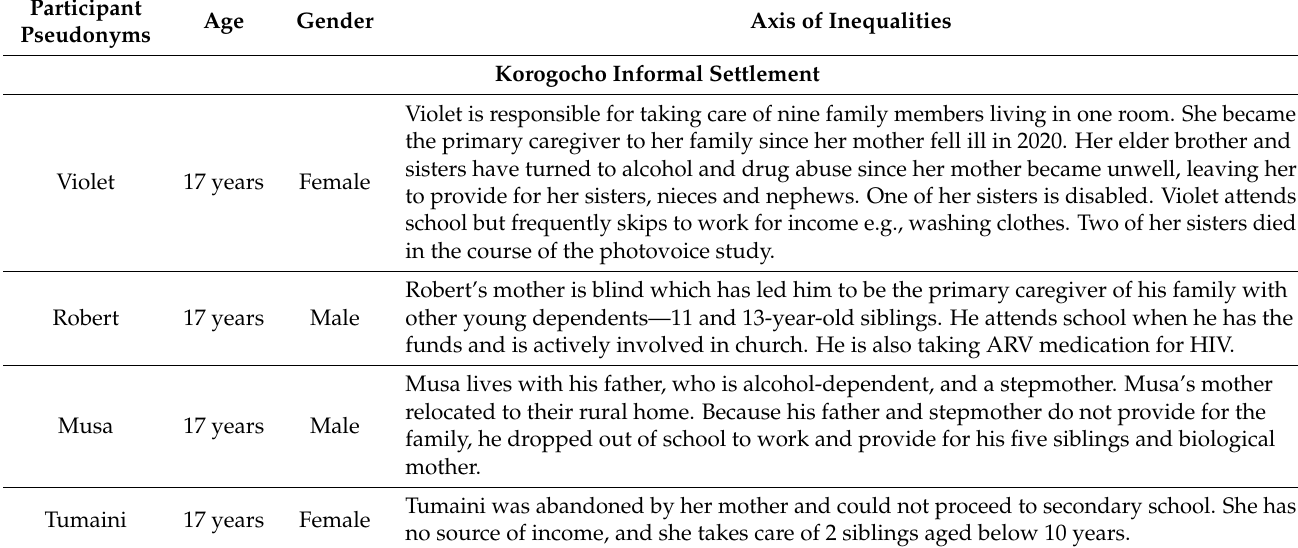
Table 2. Characteristics of CHHs in Viwandani and Korogocho informal